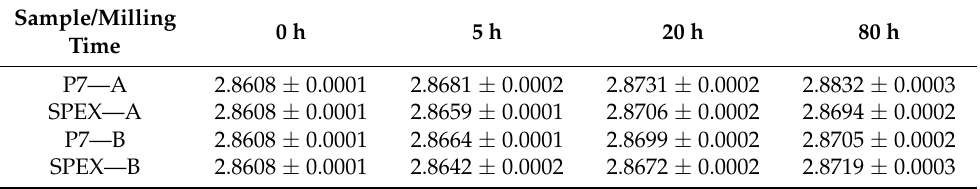
Table 1. Lattice parameter, a (Å), of the cubic bcc Fe main phase.